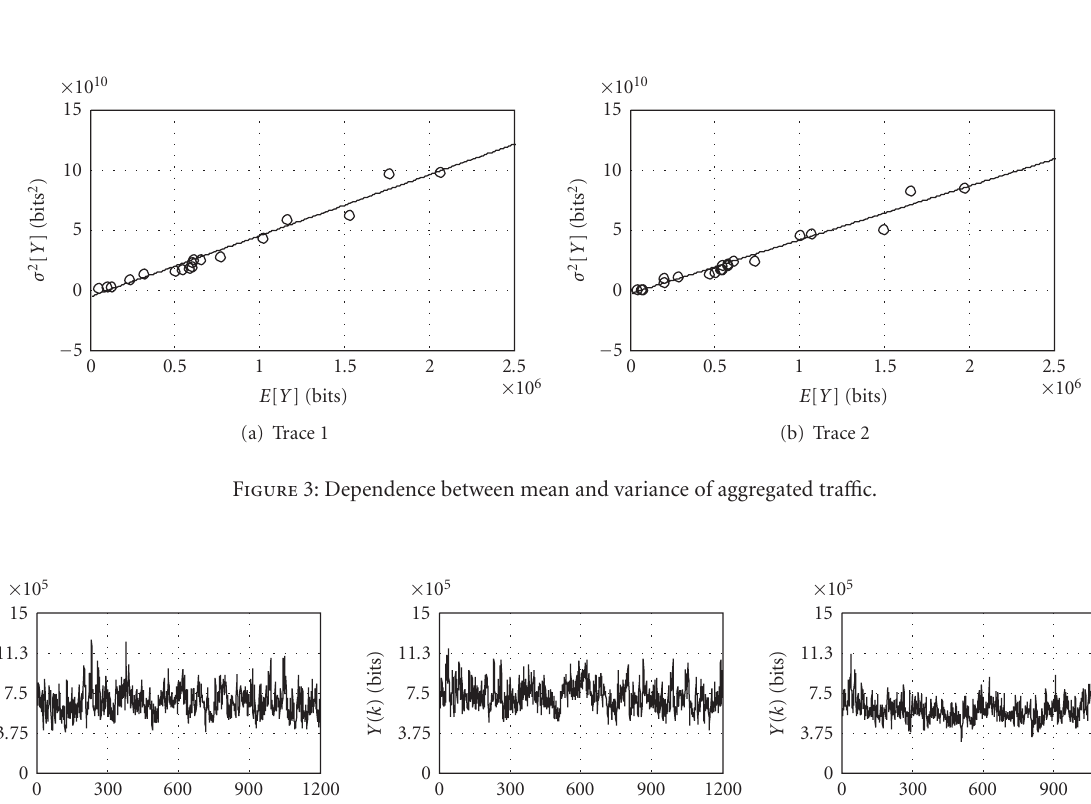
Figure 2: Aggregated tra ffi c from varying number of sources.